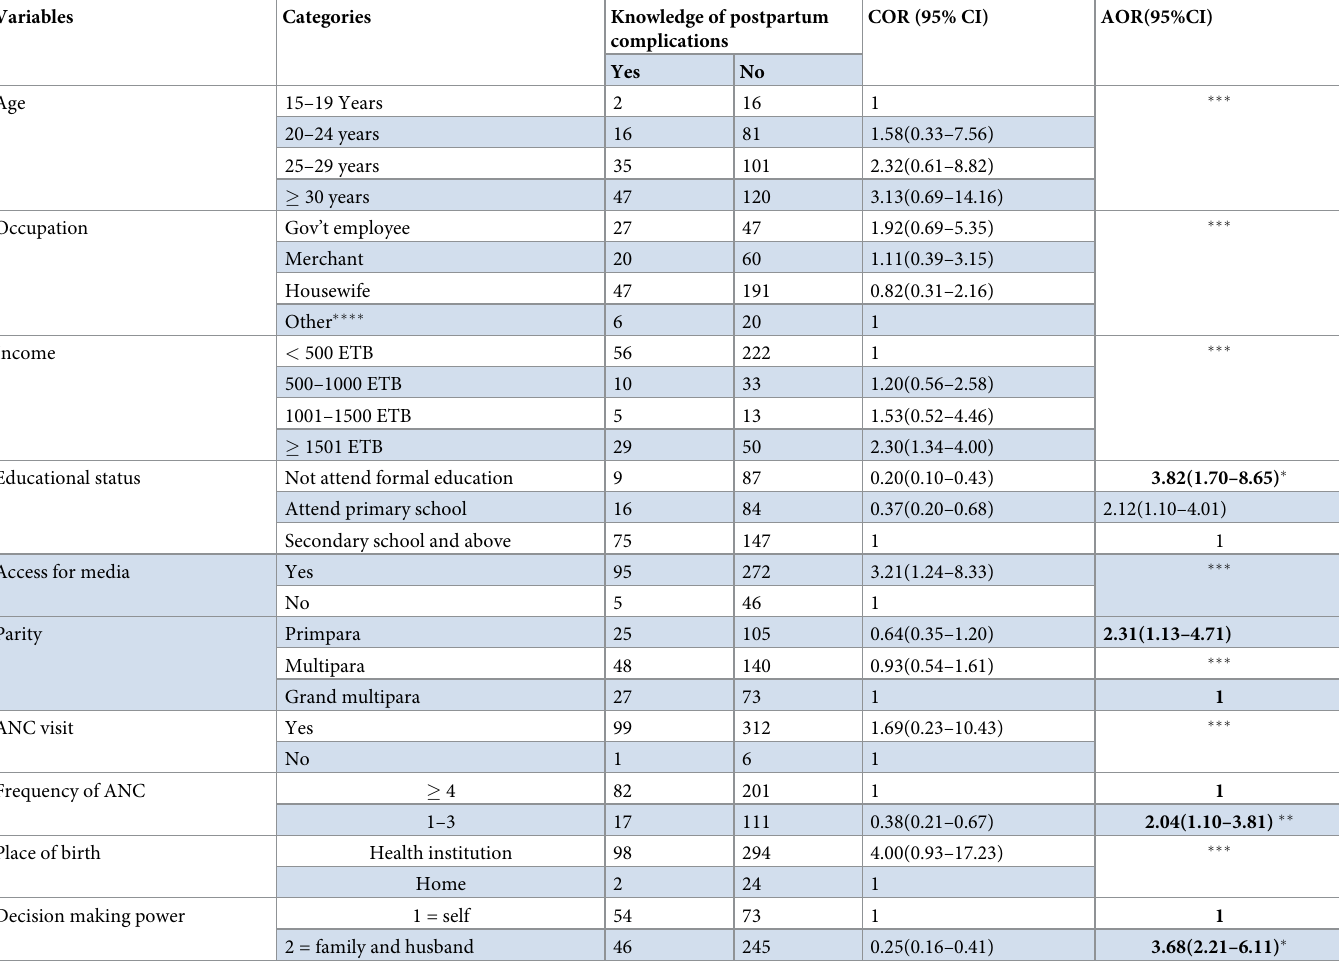
Table 3. Factors associated with mothers’ knowledge of postpartum complications in Arba Minch town, Southern Ethiopia, 2019 (n =